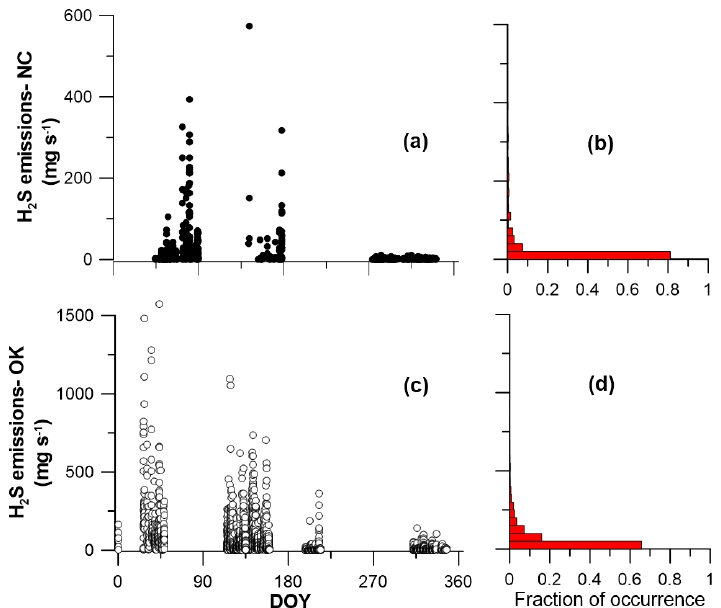
Figure 3. Half-hourly emissions at the two lagoons: ( a ) Annual variation in H 2 S emissions at the NC lagoon; ( b ) Frequency distribution of half-hourly emission measurements at the NC lagoon; ( c ) Annual variation in H 2 S emissions at the OK lagoon; ( d ) Frequency distribution of half-hourly emission measurements at the NC